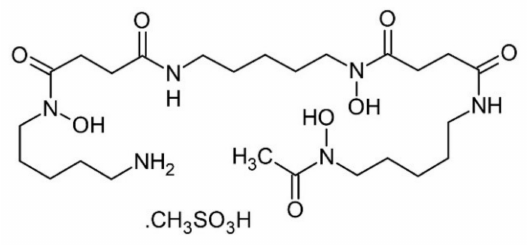
Figure 6. Molecular structure of deferoxamine mesylate.